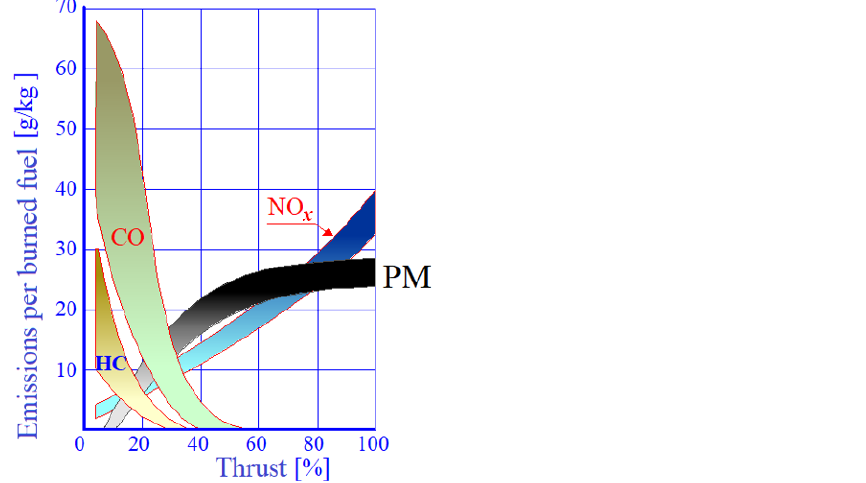
Figure 9. Emissions vs. thrust.